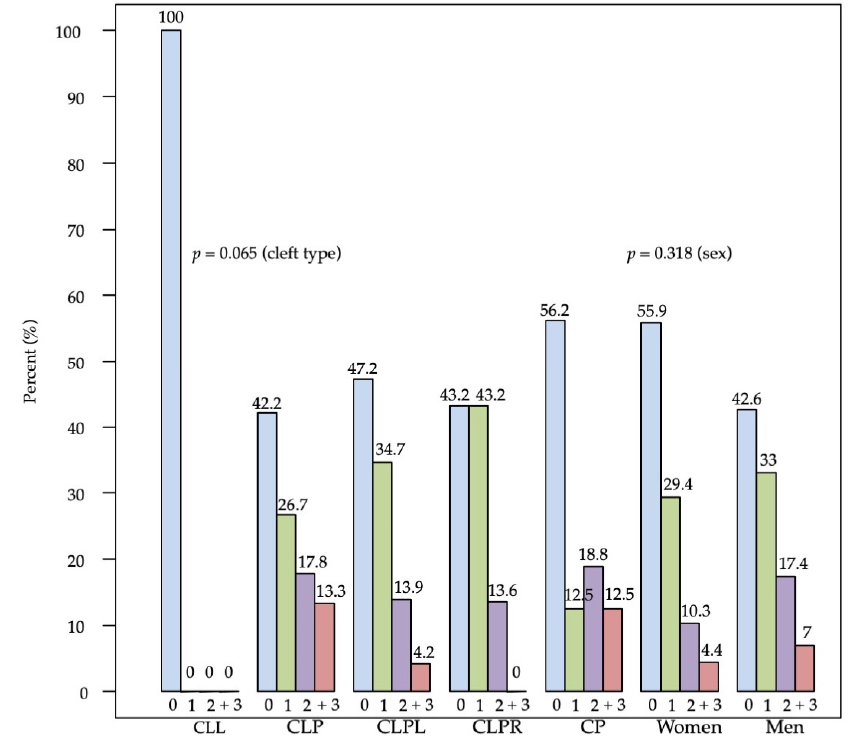
Figure 2. Prevalence of tooth agenesis by cleft type and sex.